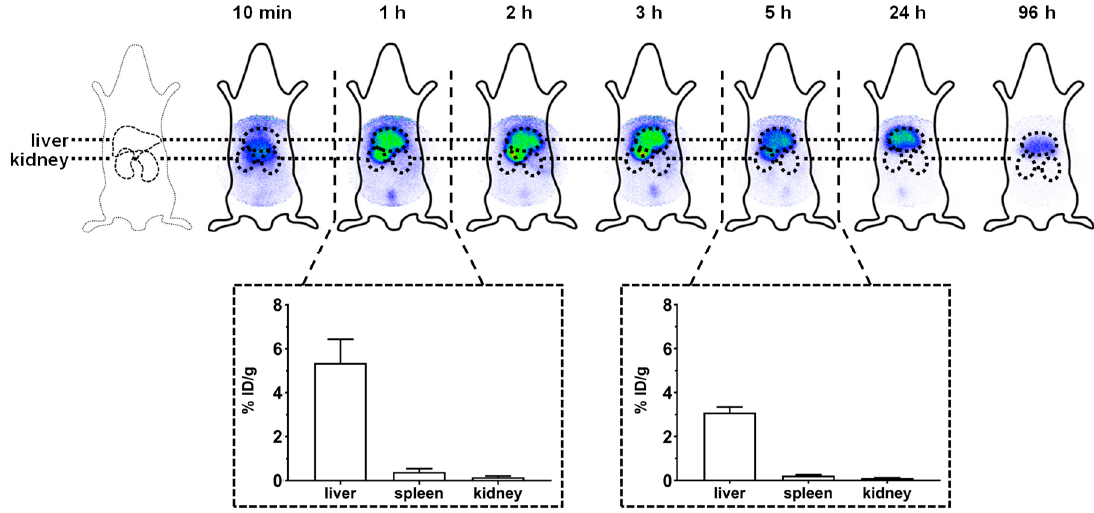
Figure 5. Scintigraphic imaging and biodistribution studies of V V -R 3 yC-C 12 . After an intravenous injection of the labeled conjugate, images were taken at several time points (10 min, 1 h, 2 h, 3 h, 5 h, 24 h, and 96 h) post injection. In an additional experiment, further Wistar rats were injected intravenously with the radiolabeled compound and euthanized after 1 and 5 h. Subsequently, the organs were removed to determine the percentage of the injected dosage per gram organ (% ID / g). Data is shown within the dotted squares (n = 3).